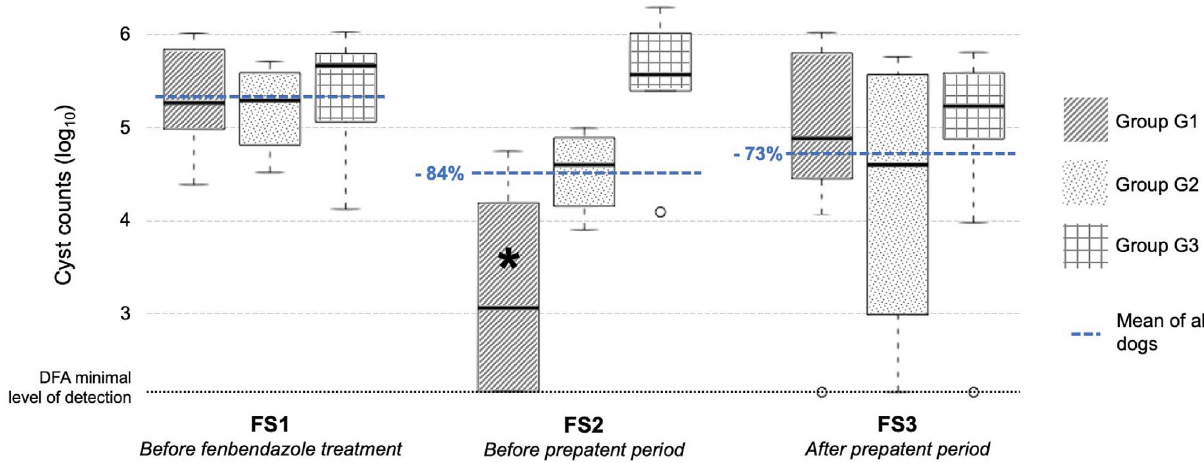
Figure 2. Cyst shedding for G1, G2 and G3 groups at FS1, FS2 and FS3 (cyst counts in log 10 ). FS1: fecal samples collected 0 – 4 days before initiation of treatment, FS2: fecal samples collected 2 – 4 days after the end of treatment, FS3: fecal samples collected 8 – 10 days after the end of treatment, G1: dogs with reduction of cysts (cid:1) 90% between FS1 and FS2, G2: dogs with reduction of cysts (cid:1) 50% and <90% between FS1 and FS2, G3: dogs with reduction of cysts < 50% between FS1 and FS2, DFA = direct immuno fl uorescence assay, *: signi fi cant reduction in cyst shedding compared with FS1.